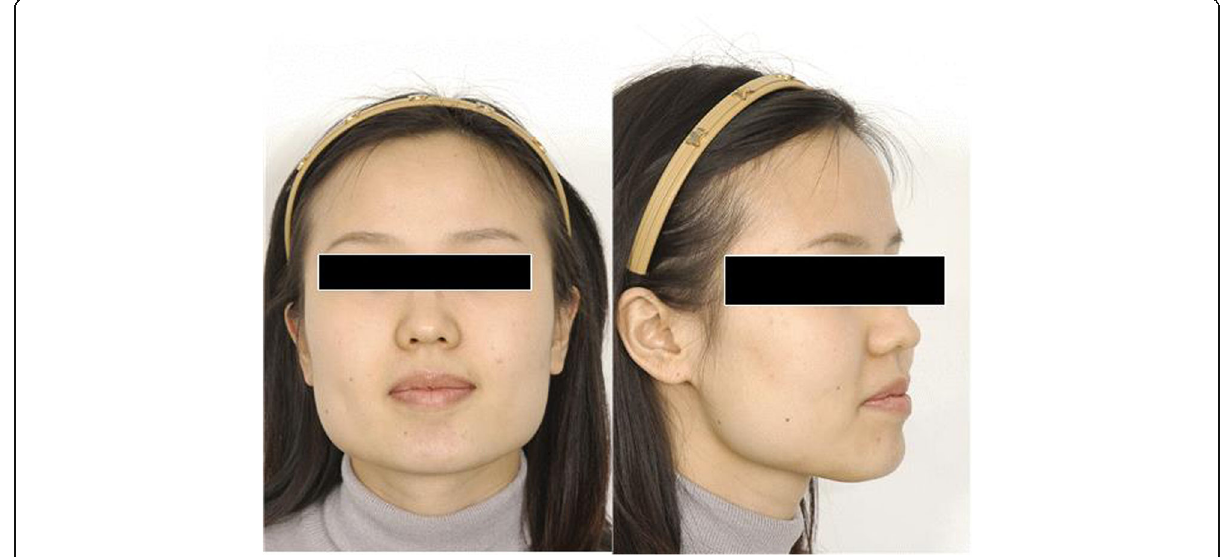
Fig. 16 Type III. Combination type. Patient with outwardly projecting mandibular angle and muscular hypertrophy is